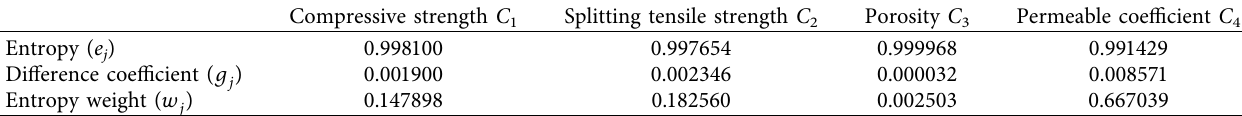
Table 7: Entropy weight calculation results of diferent basalt fber diameters.